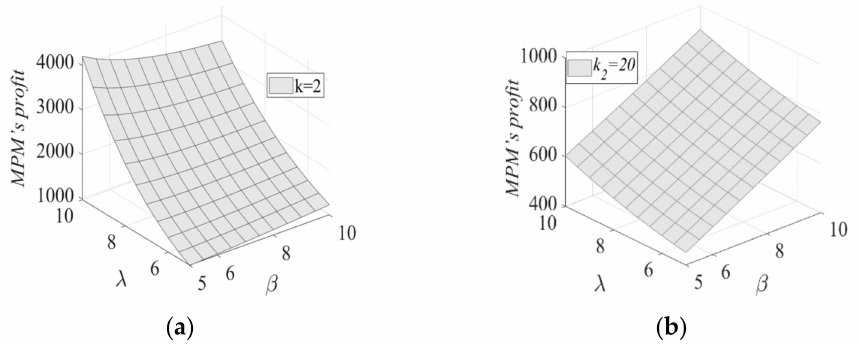
Figure 4. Impact of customers’ preferences of the recycling price and recycling service on the MPM’s profit under different service cost coefficients: ( a ) When k is small ( k 1 = 2); ( b ) When k is big ( k 2 =